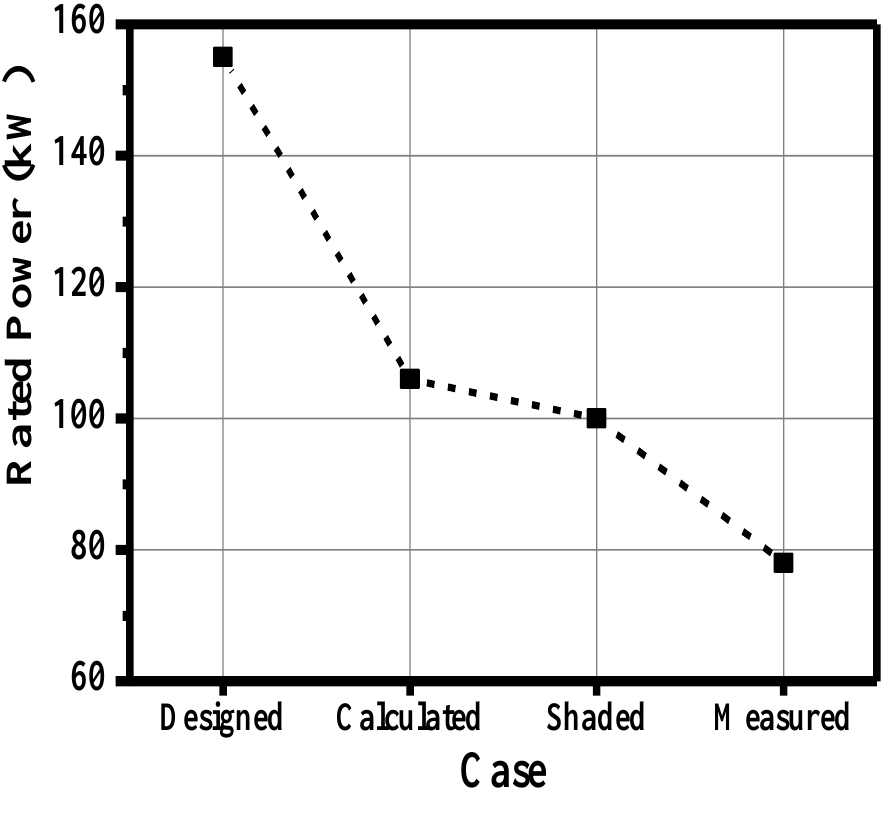
Figure (10). Effect of shade on the productivity of REERC PV